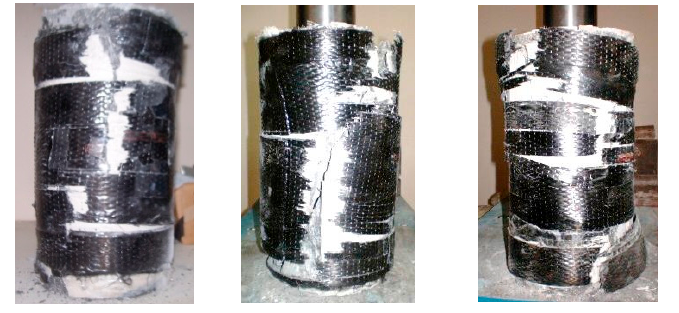
Figure 3. Dilation ratio-axial strain relationship in FRP confined HPFRCC.